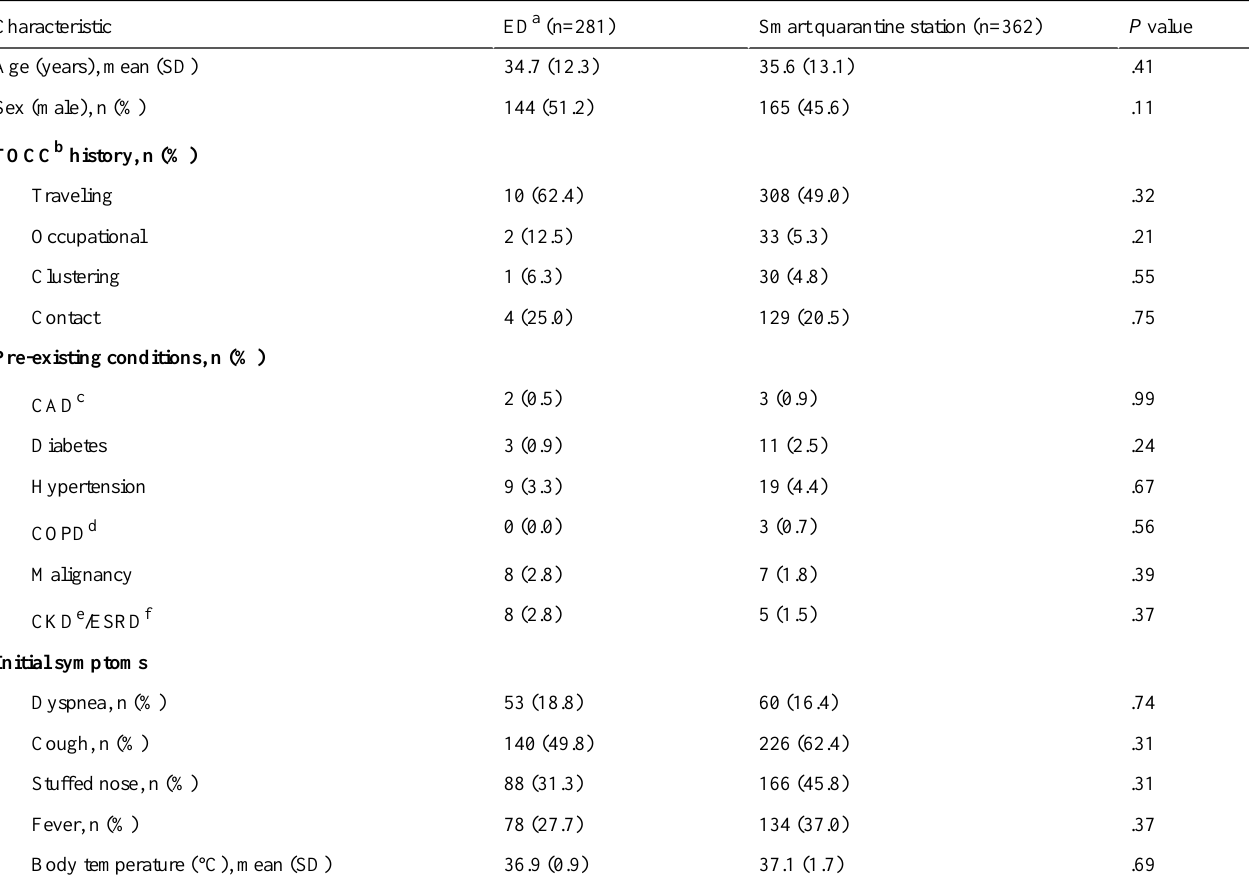
Table 1. Comparison of clinical data of patients seeking treatment in the traditional ED and at the smart quarantine station during the COVID-19 epidemic from January 31 to March 17, 2020